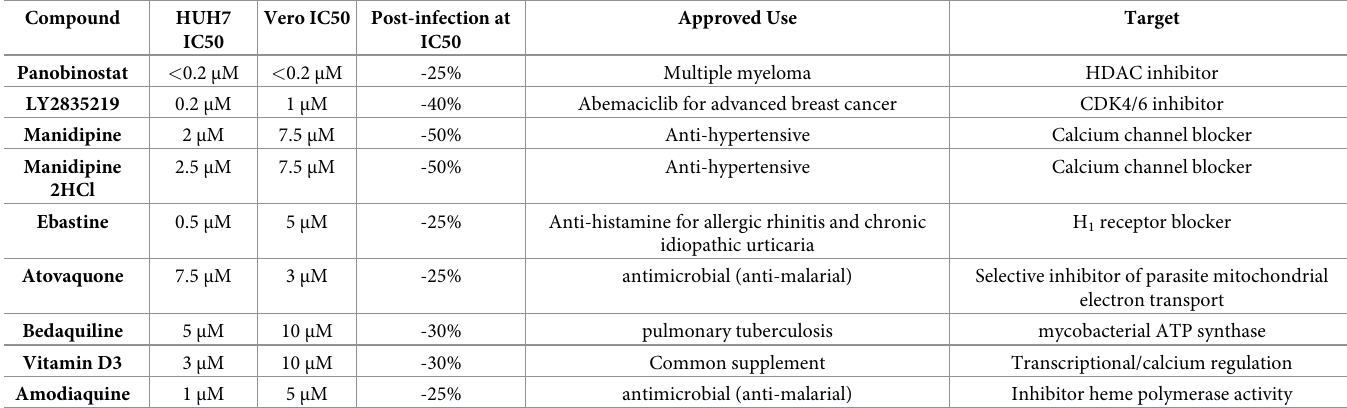
Table 1. Approved uses of the 9 compounds of interest that inhibit SARS-CoV-2 infection and replication in HUH7 cells. Compound